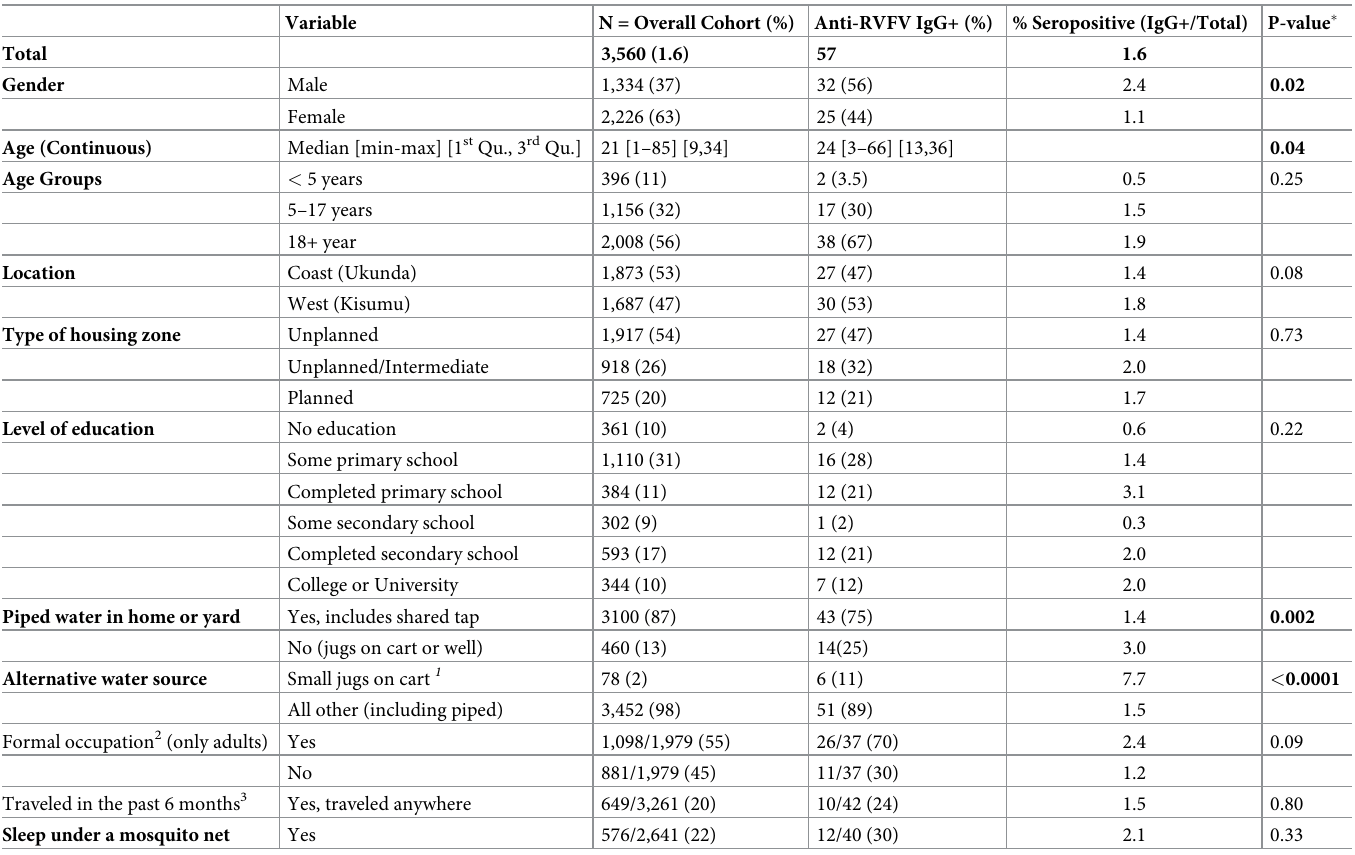
Table 1. Participant demographics overall and for RVFV seropositive participants.